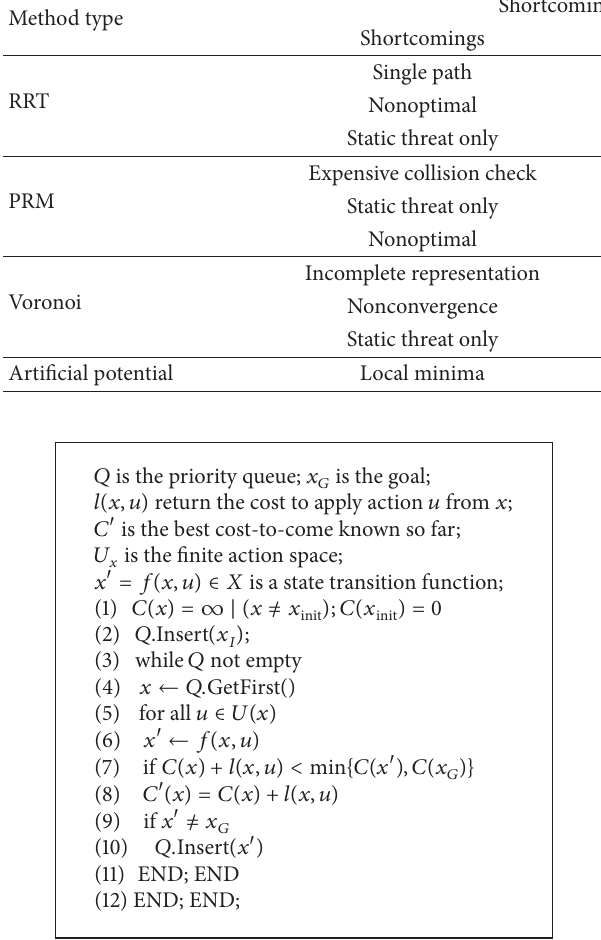
Algorithm 5: Dijkstra’s